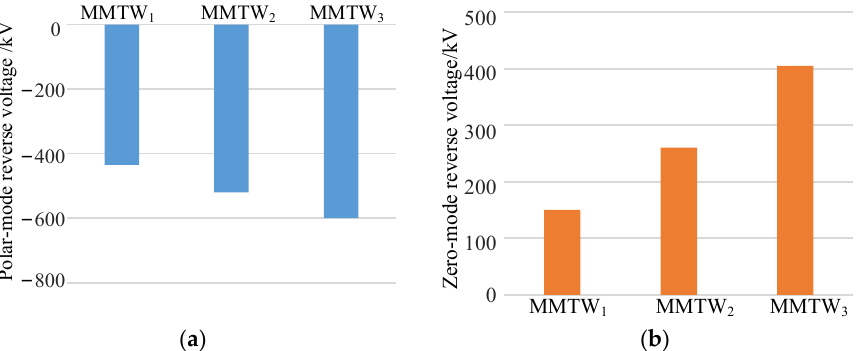
Figure 12. Wavelet transform results of maximum waveform in the negative pole to ground metal short-circuit fault signal. ( a ) Polar-mode reverse-voltage traveling wavelet mode maximum waveform; ( b ) zero-mode reverse-voltage traveling wavelet mode extreme waveform. The simulation results of when a bipolar metallic ground short-circuit fault occurs at the midpoint of DC line L 1 are shown in Figure 13. The occurrence of a bipolar short-circuit fault results in an instantaneous drop of both the polar-mode voltage and polar-mode reverse-voltage traveling waves of the DC line, with a drop amplitude that is approximately twice that of a unipolar fault. The polar-mode voltage subsequently experiences a slow rise to the peak value, while the polar-mode reverse-voltage traveling wave remains unchanged. Conversely, the zero ‐ mode voltage and zero ‐ mode reverse ‐ voltage traveling waves of the DC lines remain unaltered before and after the fault, maintaining a value of zero.